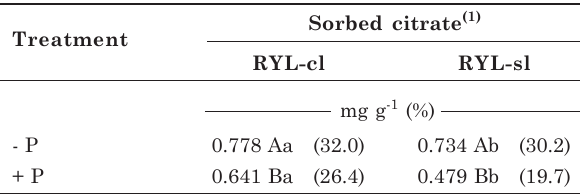
Table 3. Cumulative concentrations, in the collection period of 0 to 62 min, of citrate sorbed to soils with clayey texture Oxisol (RYL-cl) and sandy- loam texture Oxisol (RYL-sl) in the absence and presence of P